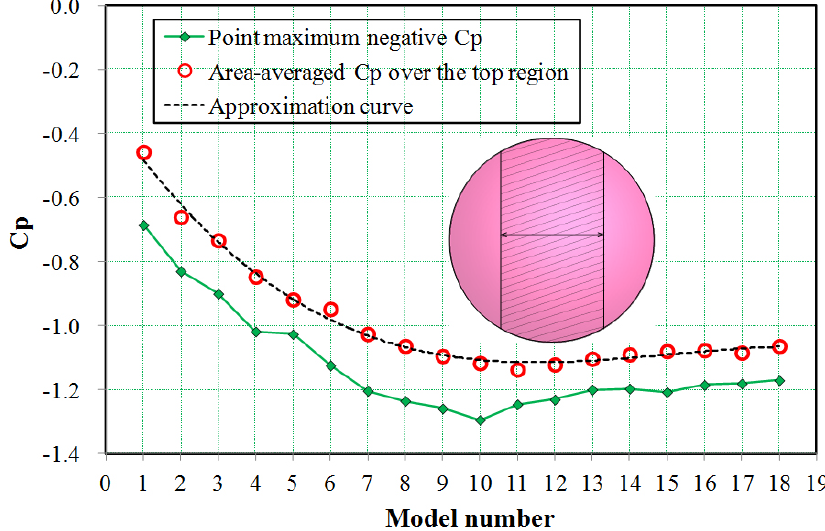
Figure 11. Point-maximum negative Cp and area-averaged Cp over the top region (reference height: H ).